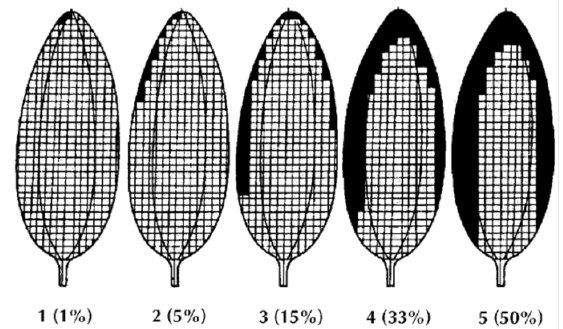
Figure 1. Sigatoka severity scoring. Adapted from